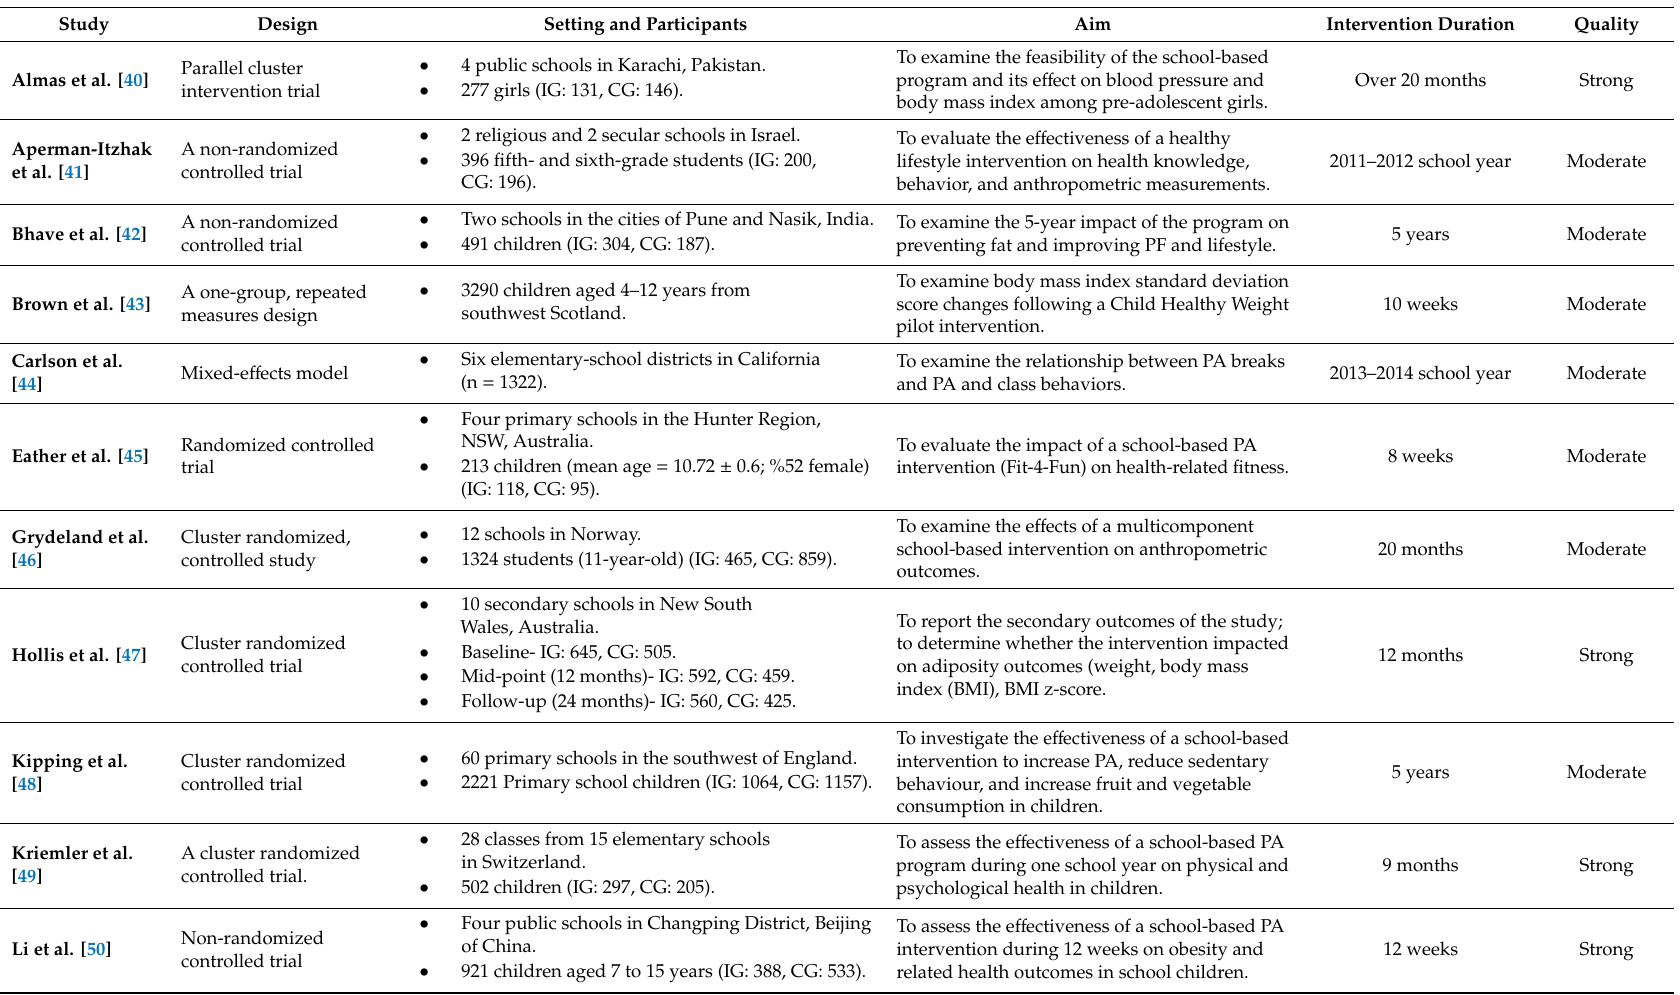
Table 2. Summary of school-based intervention